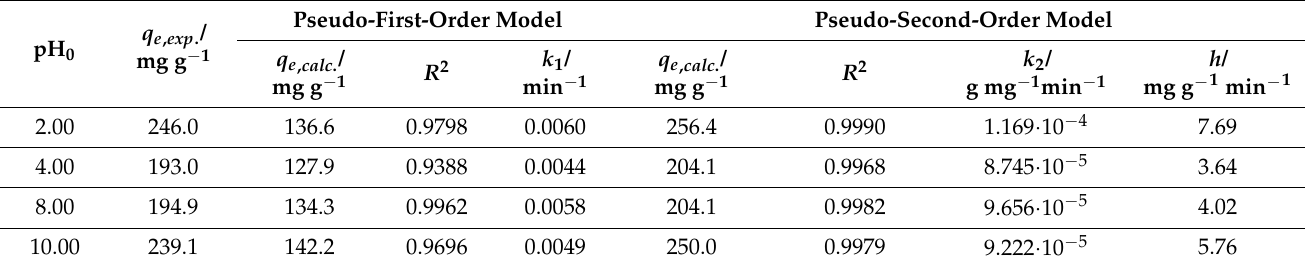
Table 3. Kinetic parameters for RB5 dye adsorption on activated carbon for different initial pH